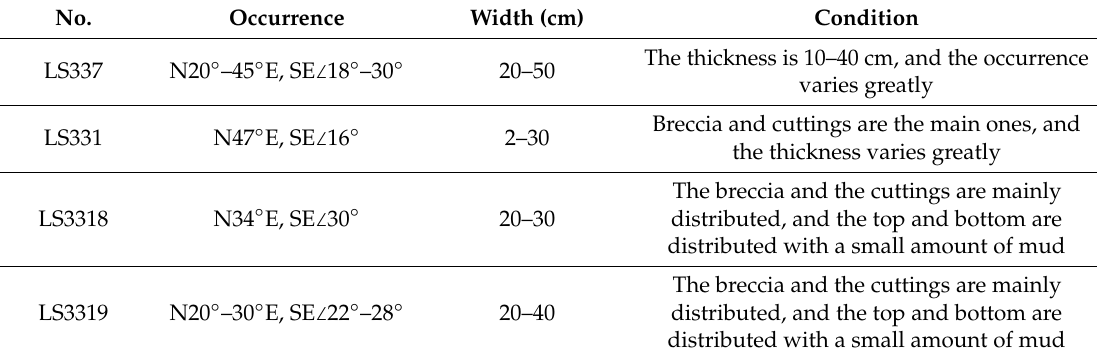
Table 3. Intraformational disturbed